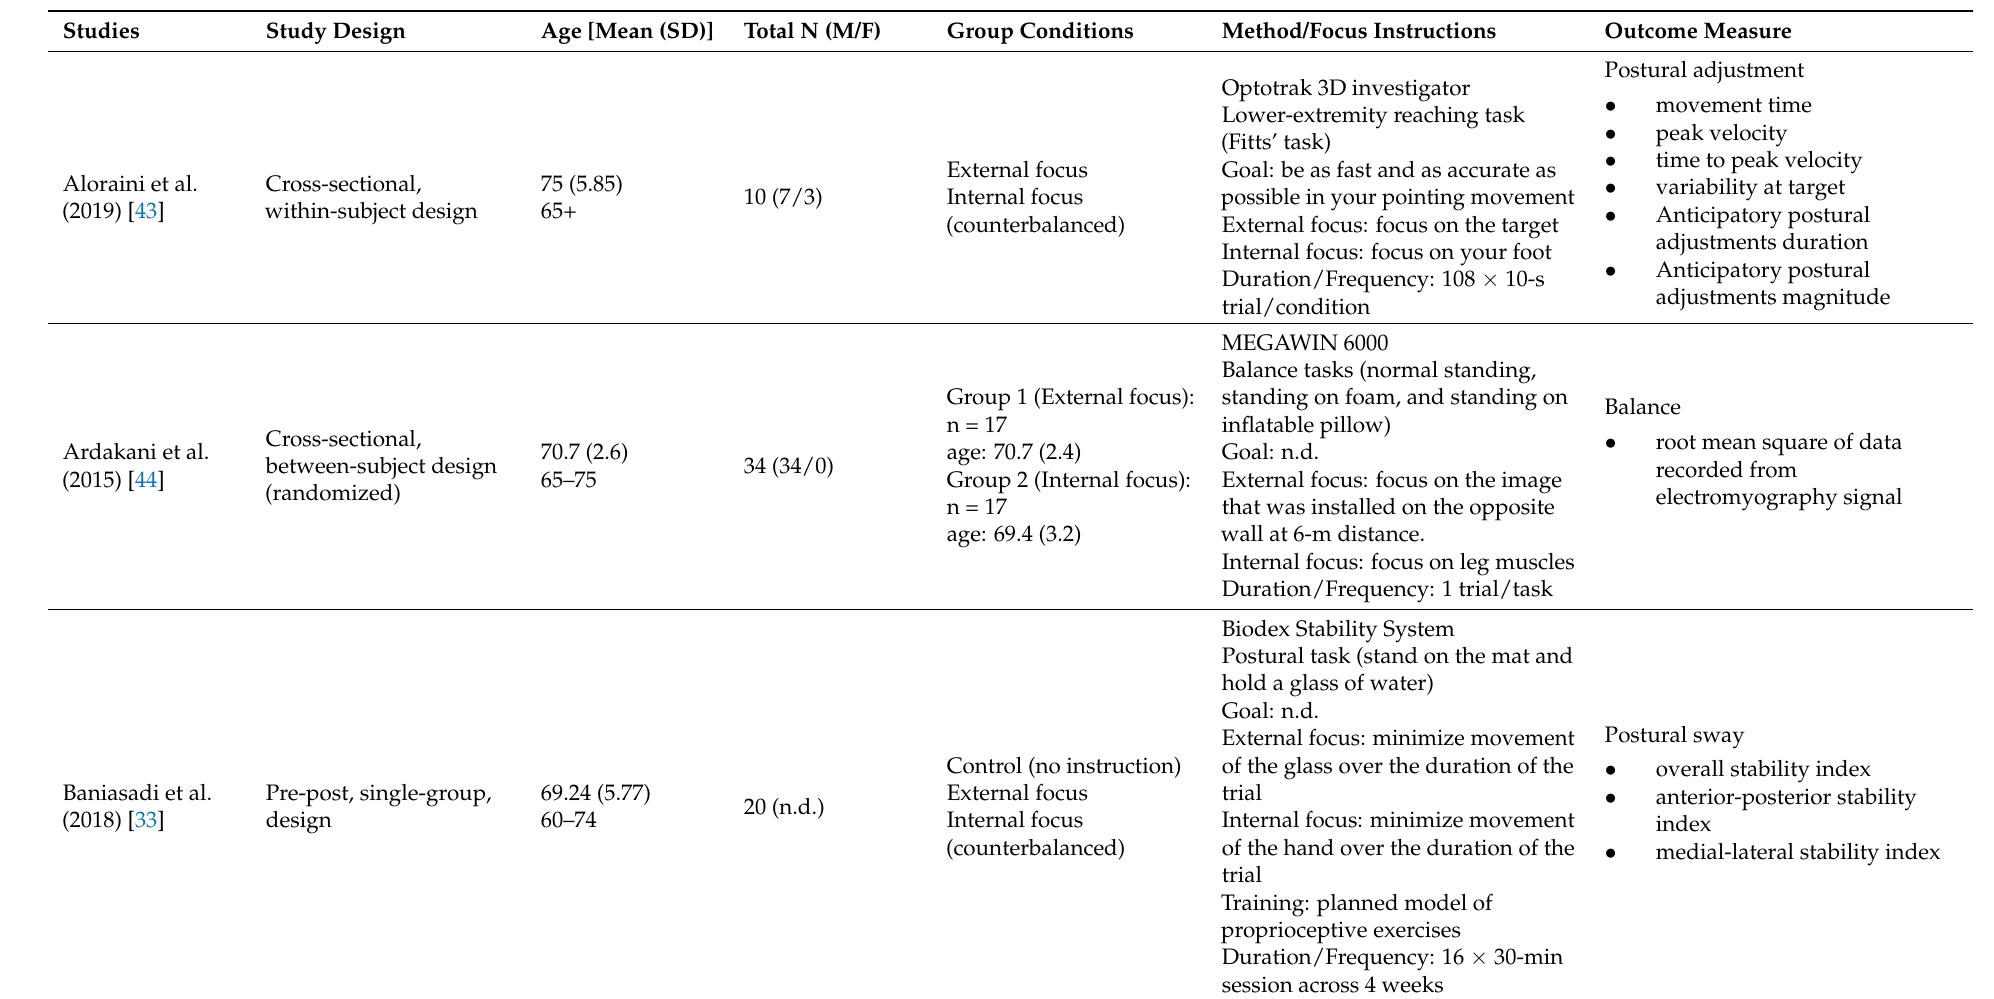
Table 3. Summary of the Characteristics of the Reviewed